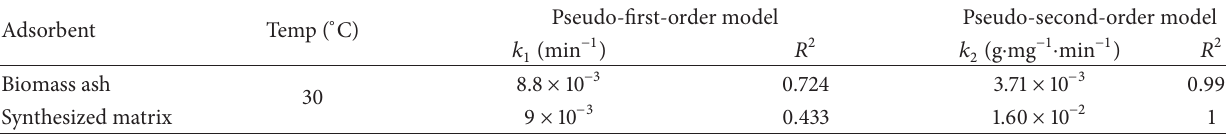
Table 5: Kinetic parameters for biomass ash and the synthesized matrix.